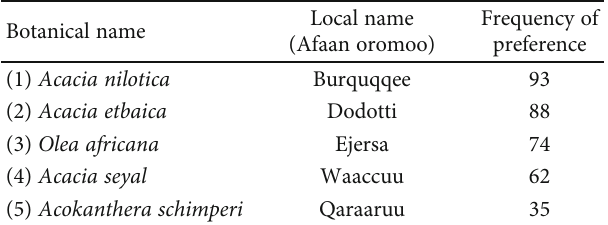
Table 1: The tree species identi fi ed by key informants for fi rewood and the number of times each was mentioned among those selected species by the